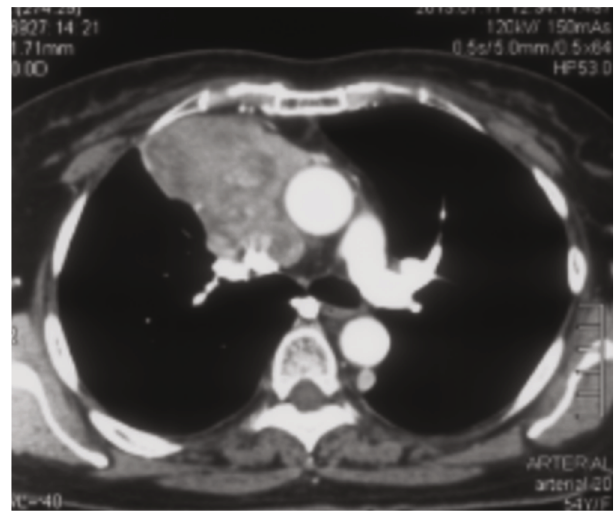
Figure 1: Huge thymic tumor with superior vena cava in fi ltration on CECT-TAP in 2013 (prior